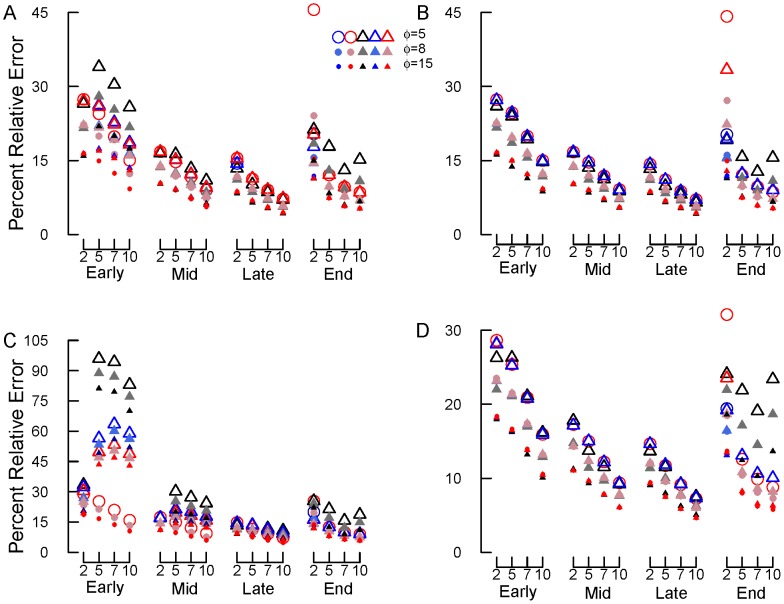
Percent relative error for beta-distributed errors plus normal errors with different σ and transformations.(A) σ = 0.0125 (option 3a) and SV transformation, (B) σ = 0.0125 (option 3a) and REP transformation, (C) σ = 0.05 (option 3b) and SV transformation, (D) σ = 0.05 (option 3b) and REP transformation. Early, mid, late and end are early, mid, late and end stage decomposition simulations. The numbers 2, 5, 7 and 10 are the numbers of measurements used in each simulation. Blue circles = NLS, Red circles = Normal ML, gray/black circles = Beta ML. In most cases, nls = Normal ML so that the red circles cover the blue circles.